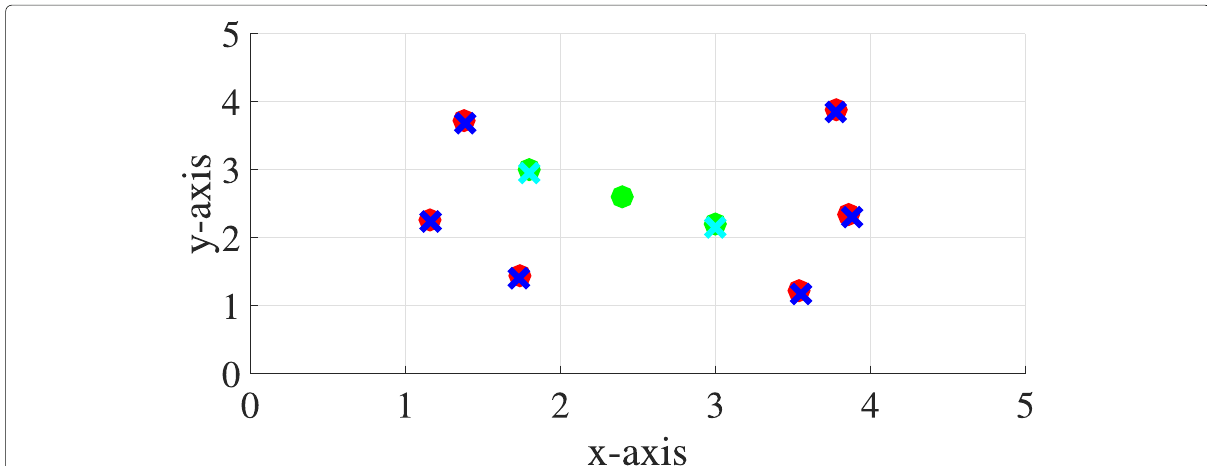
Fig. 8 The final estimated positions of the arrays and the speakers vs. the oracle positions.The oracle positions of the arrays are denoted by green circles and the estimated positions are denoted by cyan “x”s. The oracle positions of the speakers are denoted by red circles and the estimated positions are denoted by blue